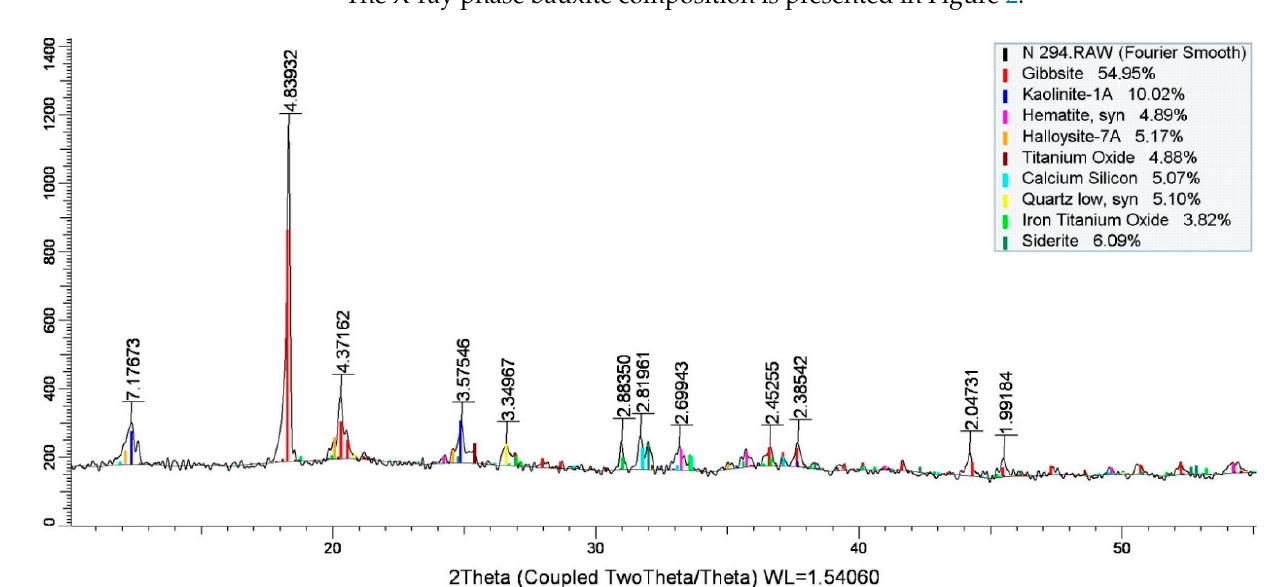
Figure 2. X-ray diffraction pattern of bauxite from the Krasnogorsk deposit. The data were previously given in the publication [16].